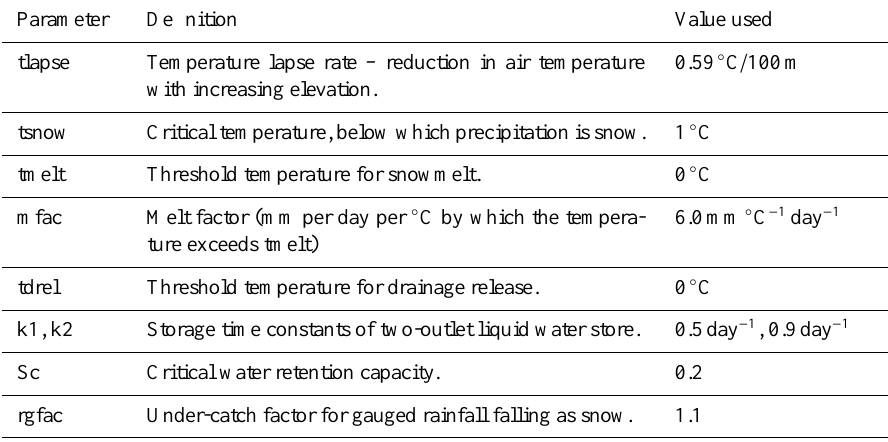
Table 3. Snowmelt model